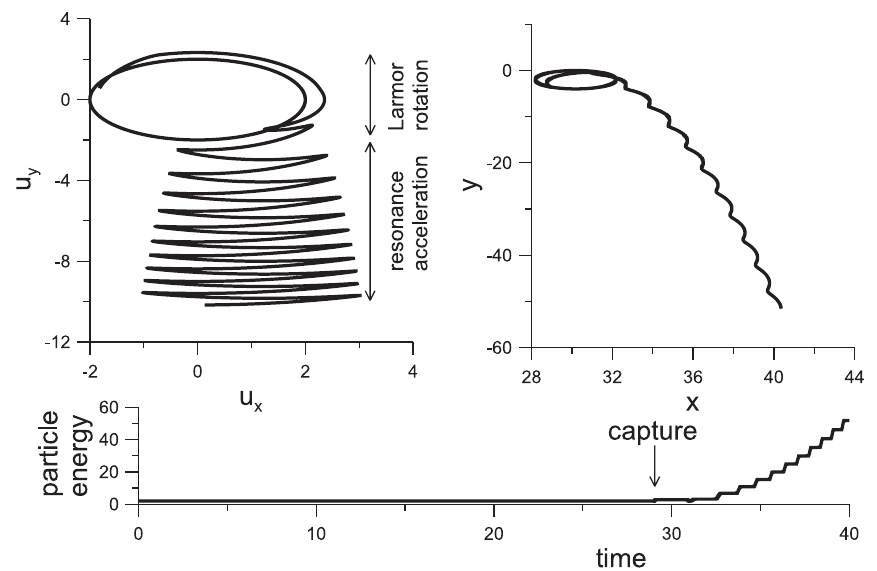
Fig. 2. The resonance particle trajectory is shown in the velocity and coordinate spaces. Also the particle energy (u 2 x + u 2 y )/ 2 as a function of dimensionless time tω n is